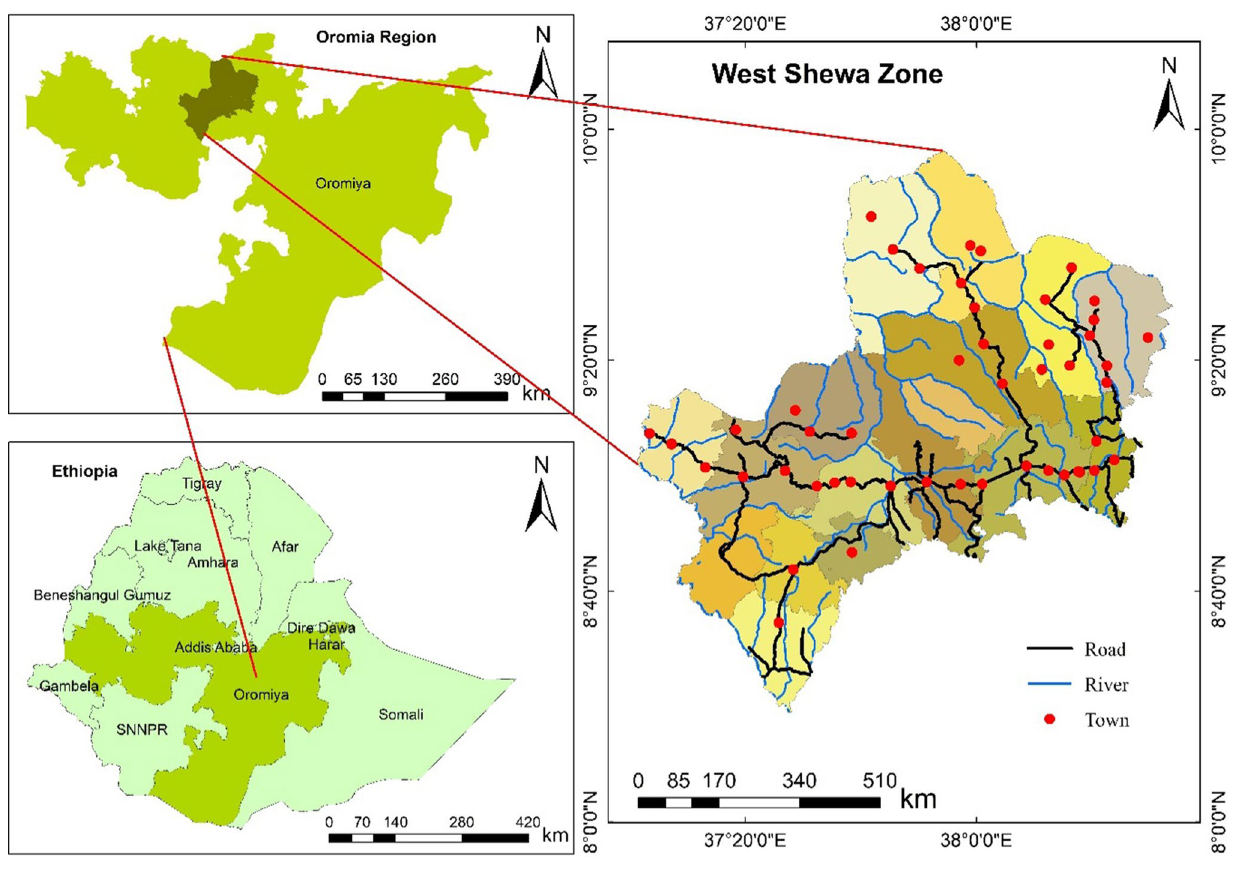
Fig. 1 Location map of West Shewa zone, Oromia, Ethiopia